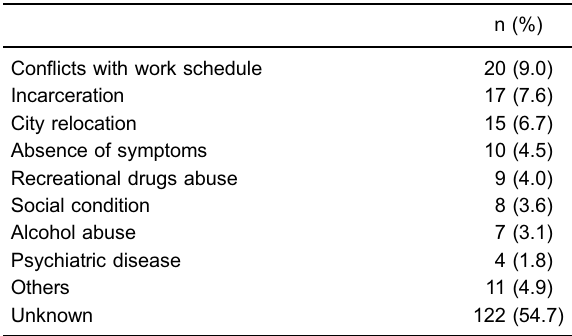
Table 4. Reasons for loss to follow-up among 223